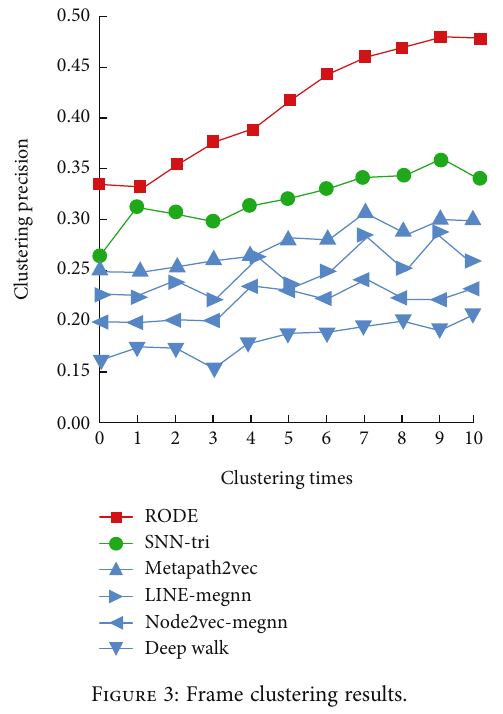
Figure 3: Frame clustering results.